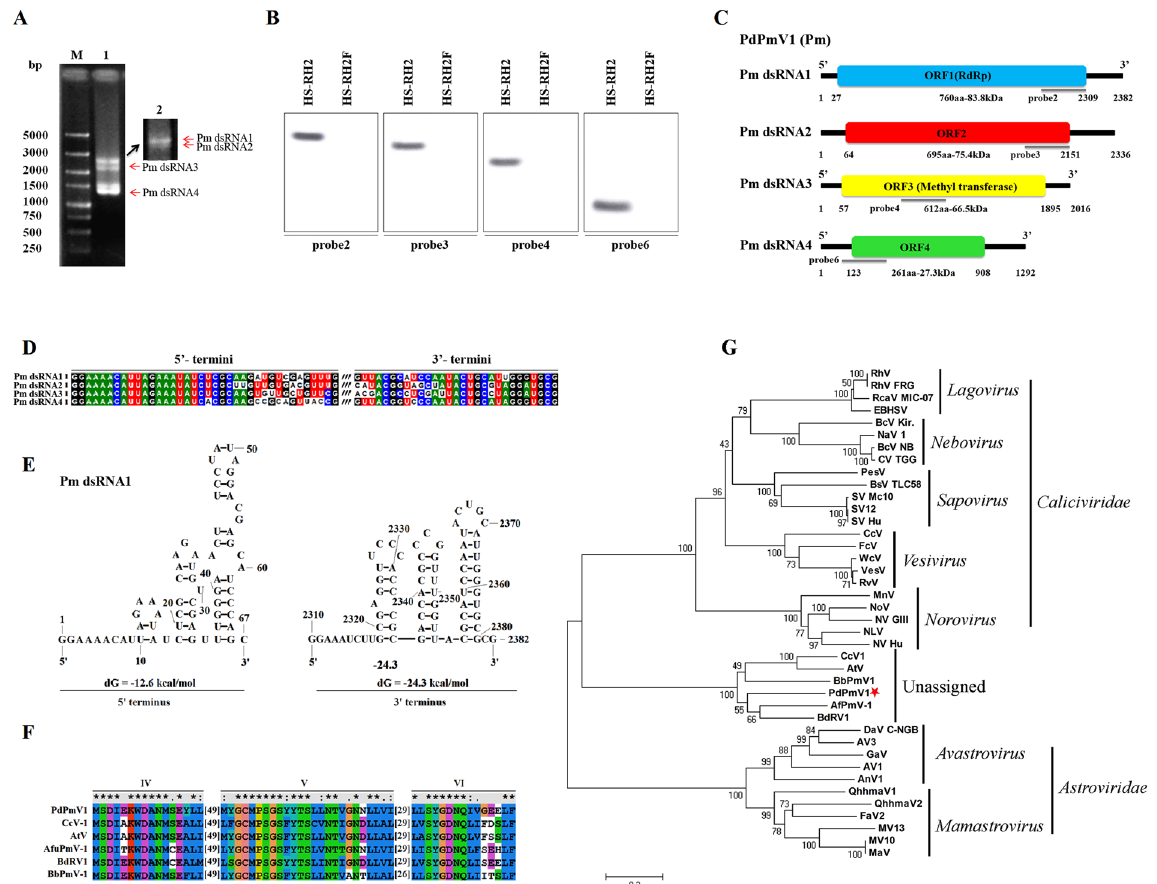
Figure 1. Molecular characterization and evolutionary analysis of PdPmV1. ( A ) Electrophoretic profile on a 1% agarose gel of dsRNA preparations extracted from P. digitatum isolate HS-RH2 after digestion with DNase I and S1 nuclease, and stained with ethidium bromide (lane 1). PdPmV1 (Pm) dsRNA1 and dsRNA2 were separated through 2% agarose gel electrophoresis (lane 2 and the corresponding full gel image was shown in Fig. S5). The Pm dsRNA1 to 4 were indicated by red arrow. Lane M, DNA size marker (DS 5000, TaKaRa, Dalian, China). ( B ) Northern blot analysis of PdPmV1 dsRNAs in HS-RH2 and HS-RH2F. The dsRNAs were separated under denaturing electrophoresis conditions, blotted onto nylon membranes, and probed by DIG- labeled DNA fragments (Fig. S6). The position of the probes (probe 2, 3, 4 and 6 to blot Pm dsRNA1 to 4 respectively) was shown in panel C. ( C ) Schematic representation of the genetic organization of PdPmV1. ( D ) Conserved sequences of the 5 ′ -termini and 3 ′ -termini of the dsRNAs of PdPmV1. ( E ) Secondary structures proposed for the terminal regions of Pm dsRNA1 with the lowest energy. ( F ) Comparison of the conserved motifs of RdRps encoded by PdPmV1 and other selected mycoviruses. The alignment was performed by the program CLUSTAL_X with manual modification. Three conserved RdRp motifs corresponding to motifs IV, V, and VI were shown. The asterisks signified identical amino acid residues, colons signified highly conserved residues, and single dots signified less conserved but related residues. Numbers within the brackets indicated the number of aa not shown. ( G ) Phylogenetic analysis of PdPmV1 RdRp and other selected RdRps. Members of the families Astroviridae , Caliciviridae and the proposed Polymycoviridae listed in Table S2 were selected, and the phylogenetic tree for RdRP sequences was constructed using the neighbor-joining method of MEGA software (version 6.0) with bootstrapping analysis of 1000